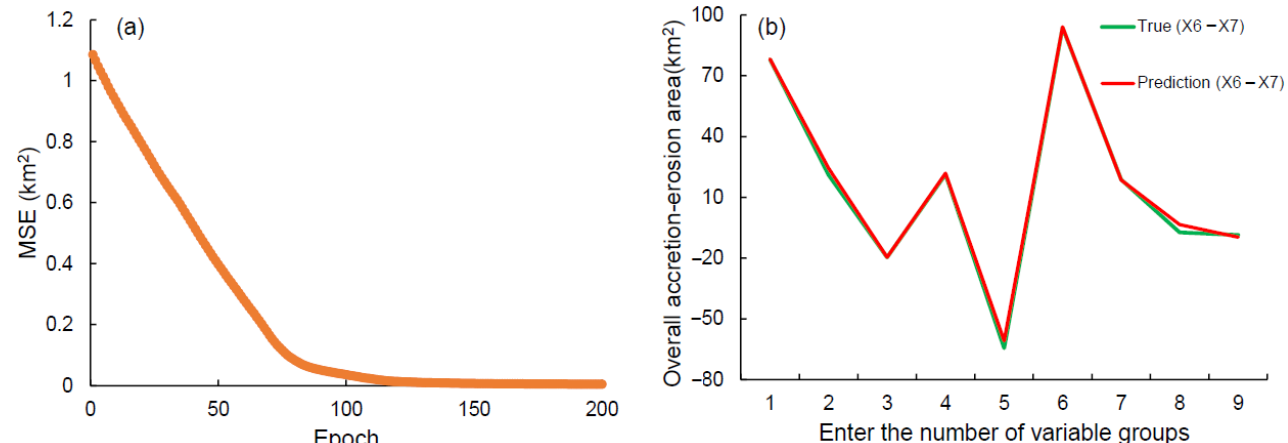
Figure 11. ( a ) Statistical performance of a lightweight smart model showing MSE between predicted and true values based on the training sets. ( b ) Comparison of the predicted overall accretion–erosion degree (variable X6 minus X7) of the Tongtian River with the true value using a lightweight intelligent model based on the test sets.